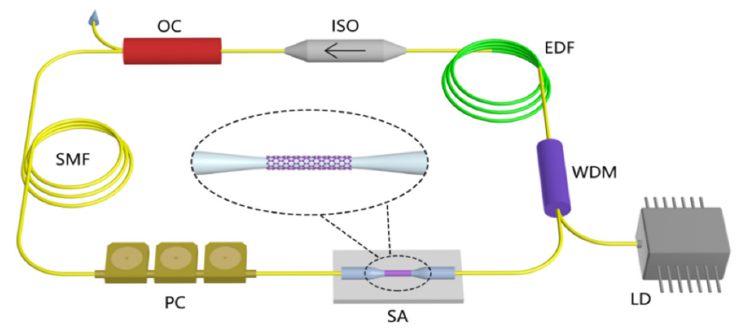
Figure 3. The experimental setup of the proposed fiber laser. LD: laser diode, WDM: wavelength- division multiplexer, EDF: erbium-doped fiber, ISO: polarization-independent isolator, OC: optical coupler, SMF: single-mode fiber, PC: polarization controller, SA: MoTe 2 -assisted fiber taper.